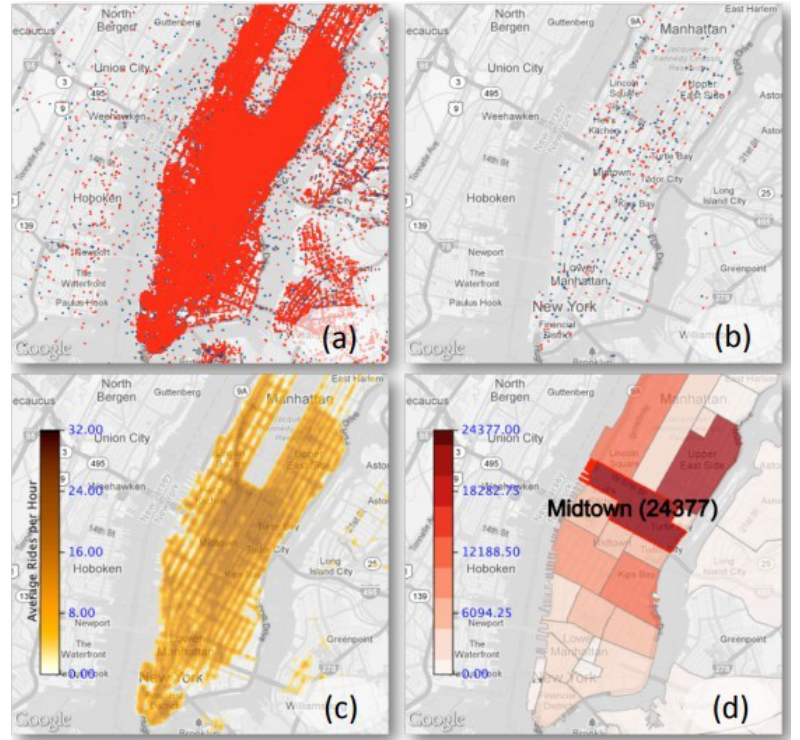
Figure 22. The ( top-left ) image shows the trips rendered on the map. However the cluttered view can be reduced by employing a level-of-detail approach ( top right ) which takes a subsample based on the order in which the trips occurred. The ( bottom-left ) image shows a density heat map of the taxi trips whereas the ( bottom-right ) image averages out the data in each region to make a regional density heat map [45]. Image courtesy of Ferreira et al.